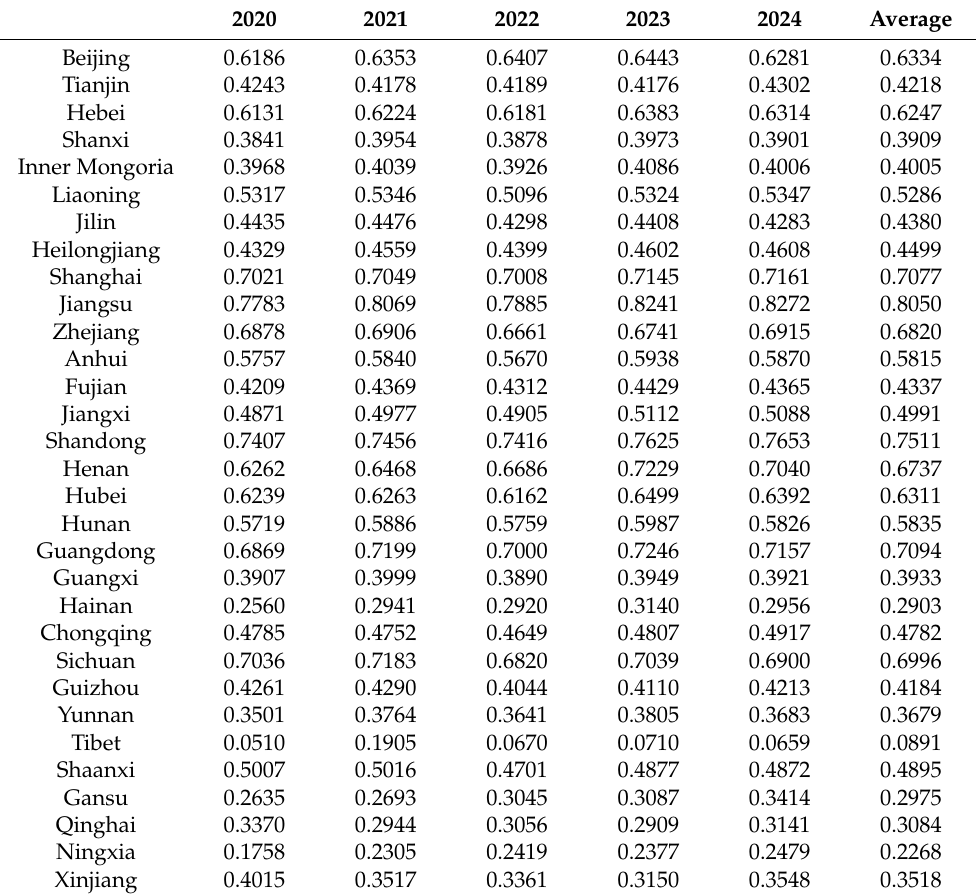
Table 5. Coupling degree of 31 regions from 2020 to 2024 (predicted